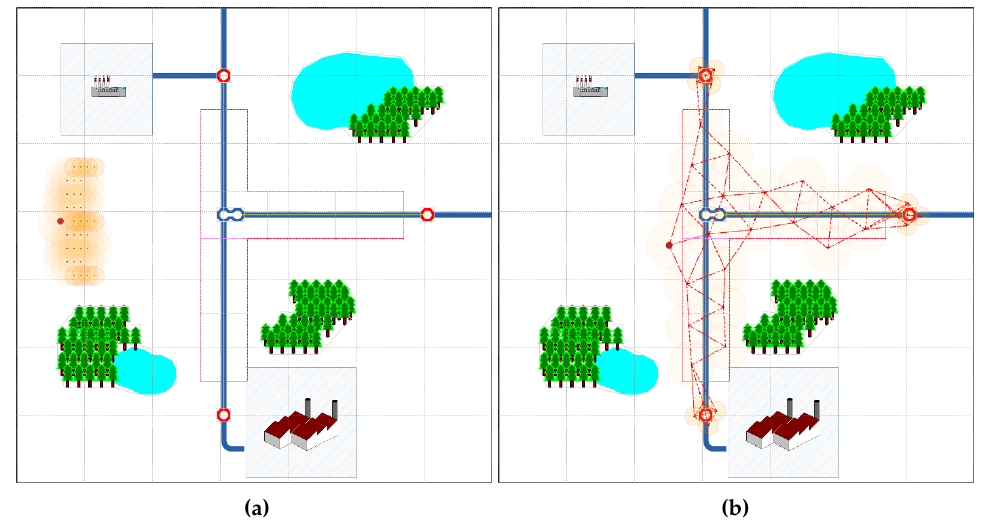
Figure 9. Topology of the sensing network: ( a ) initial topology; ( b ) final